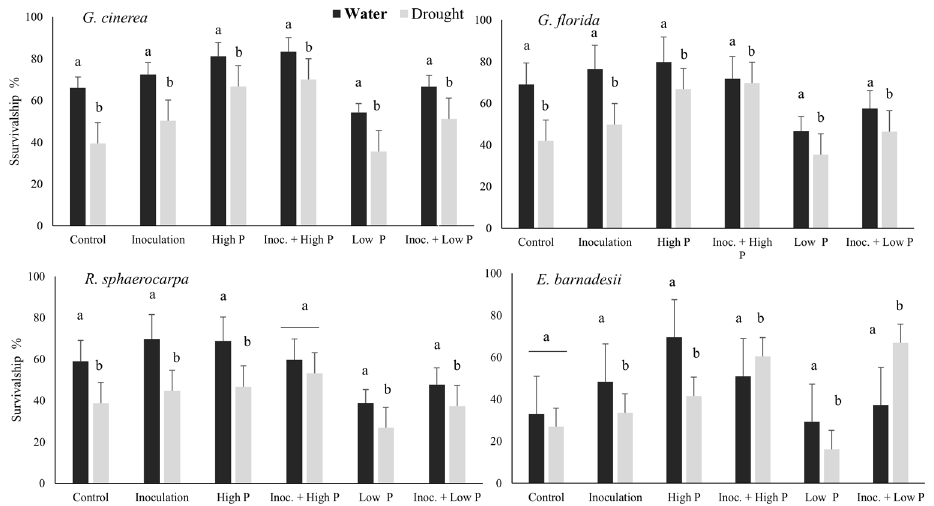
Figure 1. Survivorship of plants of G. cinerea , G. florida , E. barnadesii and R. sphaerocarpa grown under two P treatments (500 µ M and 5 µ M) with and without inoculation in well irrigated and drought-stress tests. Treatments were control, inoculation, high P, inoculation and high P, low P, inoculation and low P in water and drought condition.